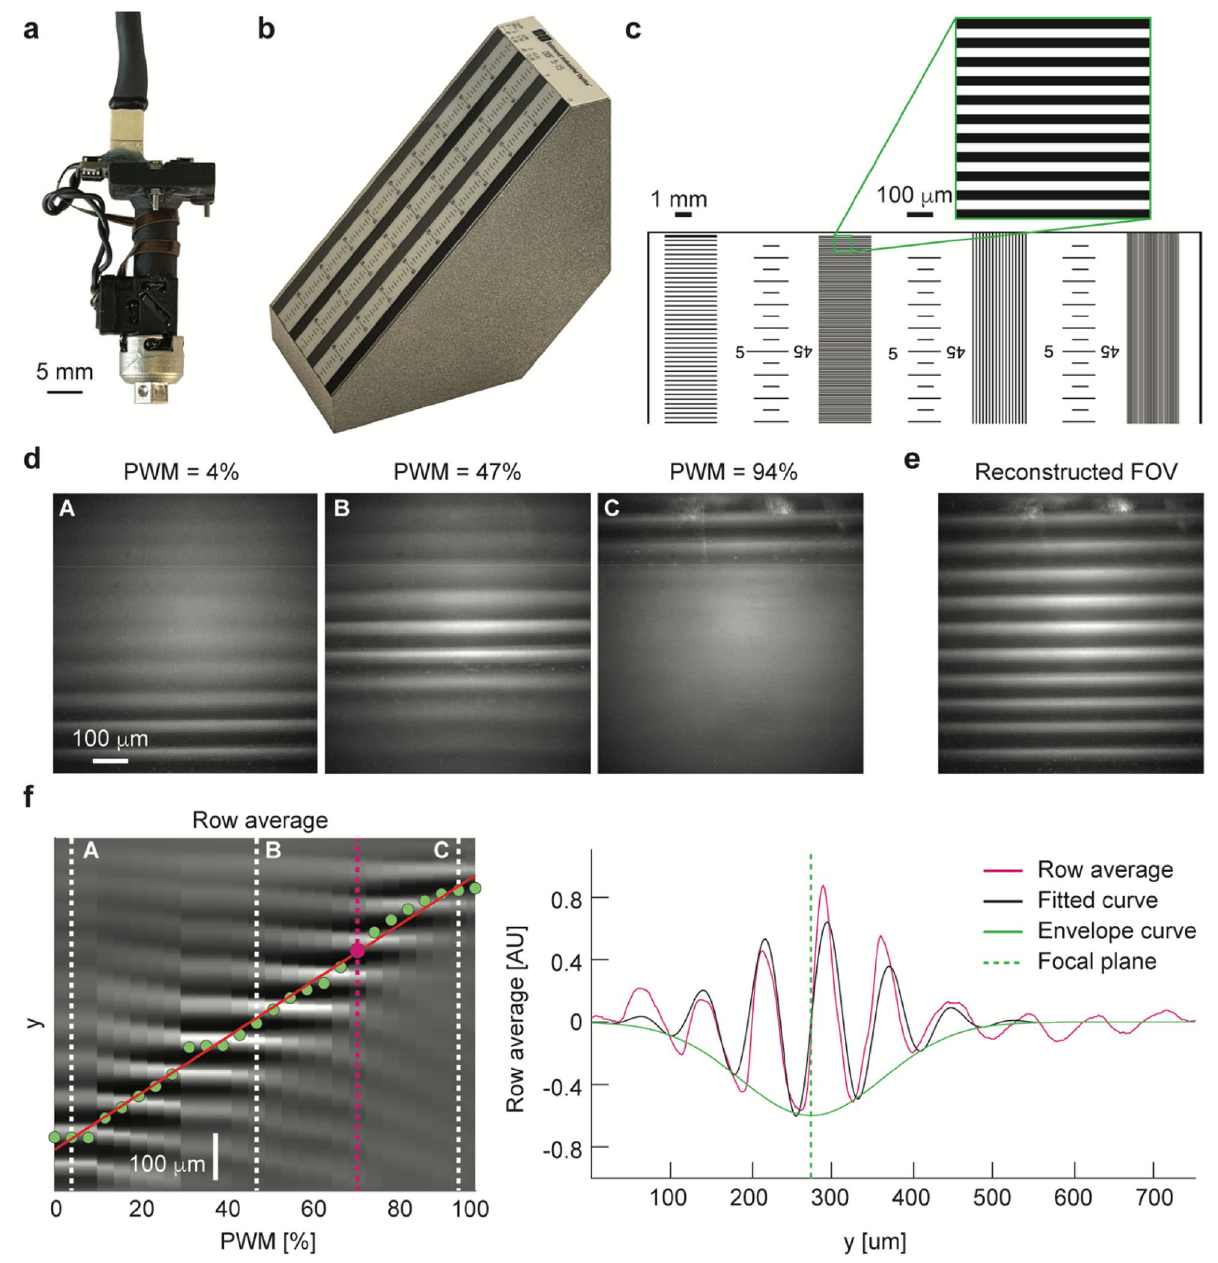
Figure 2. Evaluation of focal plane change. ( a ) The assembled miniscope was placed vertically on the depth of field target to evaluate its axial scanning performance. ( b ) A photo of the a 45° depth of field target. ( c ) Detail of the depth of filed target, highlighting a detail of the imaged field of view from the 15 lp/mm section (inset) ( d ) Images captured at 3 different focal plane depths on a 45° depth-of-field target with 15 lp/mm. ( e ) Reconstructed field of view (FOV), merging the 40 rows around the estimated focal distance for each depth. ( f ) Left: row average of images captured at different focal plane depths, spanning from 0 to 100% PWM cycle of the liquid lens control signal. Green dots show the estimated focal plane depth for each frame, and the red line is their linear fit (slope of 5.98 μm per percent change in PWM duty cycle). Dashed white lines represent the 3 frames in ( d ). Right: pixel row-average for the image captured at 66% PWM cycle control signal and shown in magenta dashed line in left panel. The center of the fitted exponential envelope curve (green dashed line) is used to estimate the focal plane